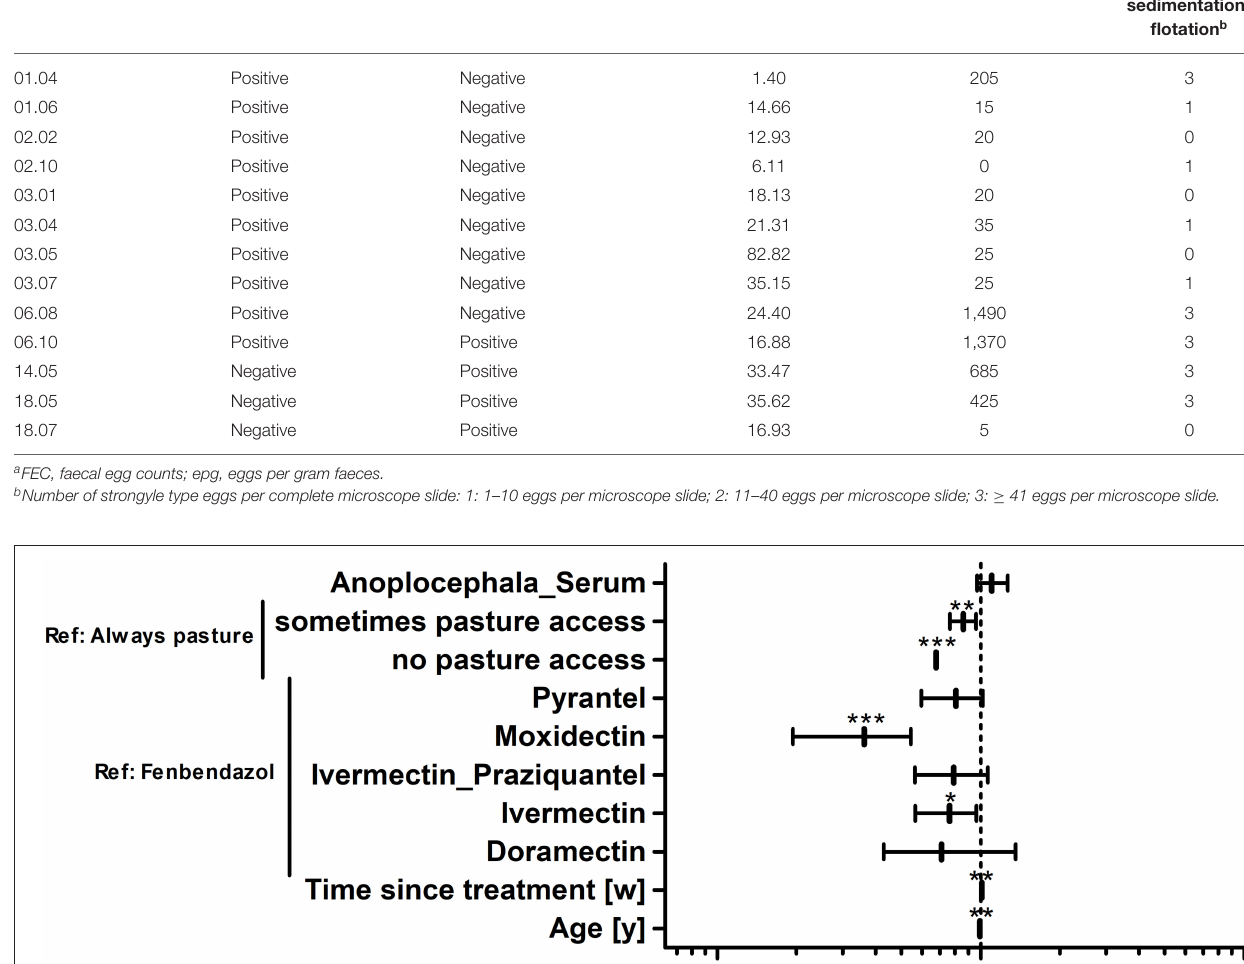
TABLE 4 | Strongylus vulgaris and Strongylus edentatus positive samples. Farm ID/Horse ID